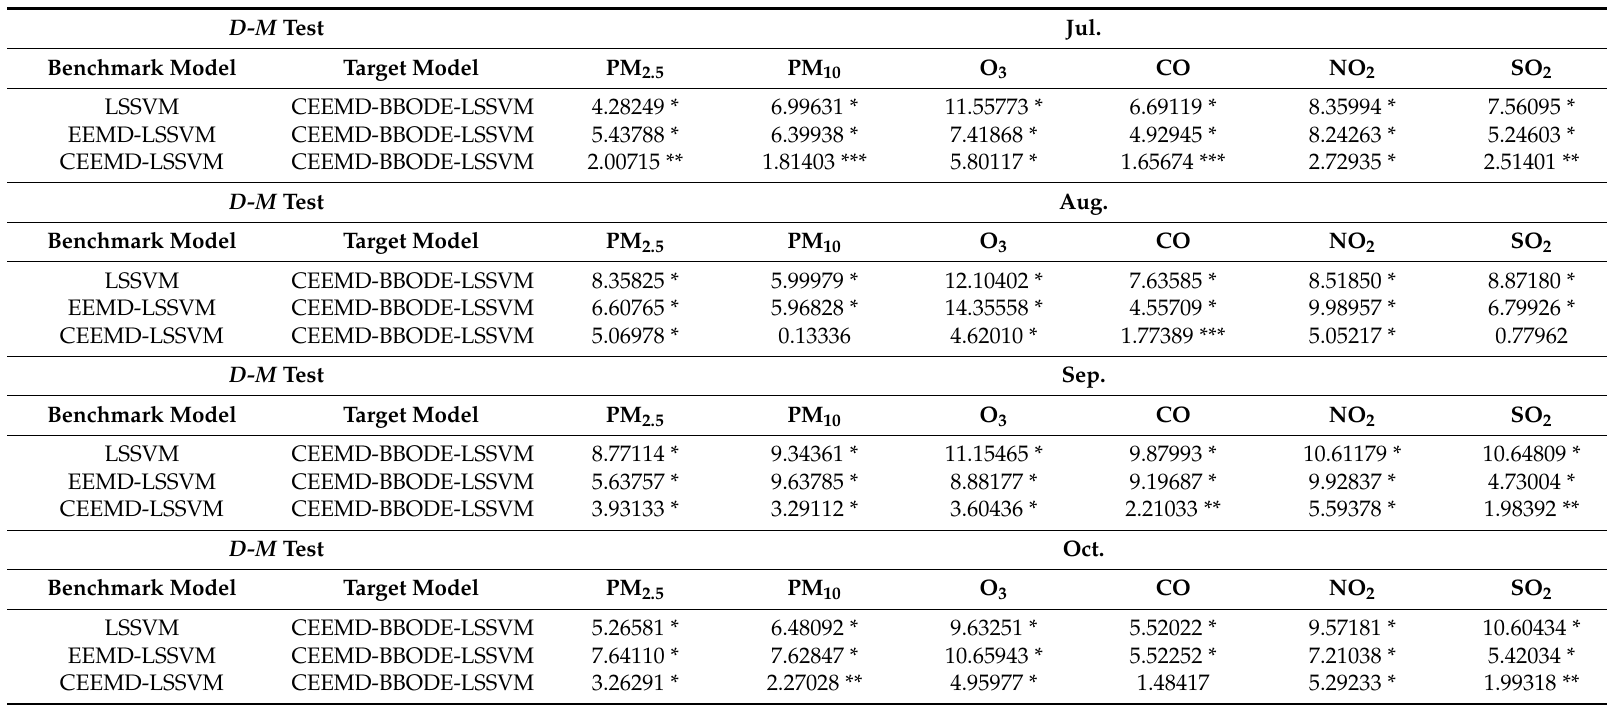
Table 15. The results of D-M